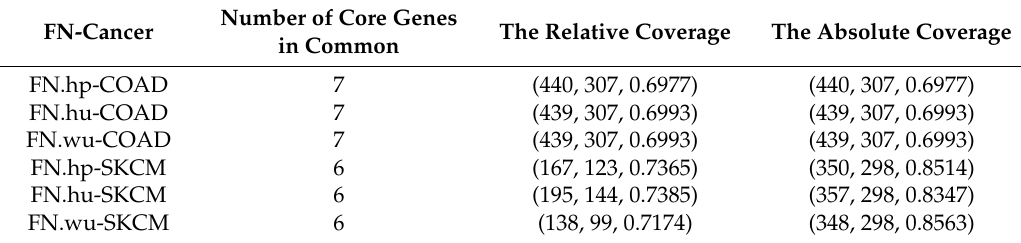
Table 2. Relative coverage and absolute coverage of samples covered by fitness cores in common for COAD and